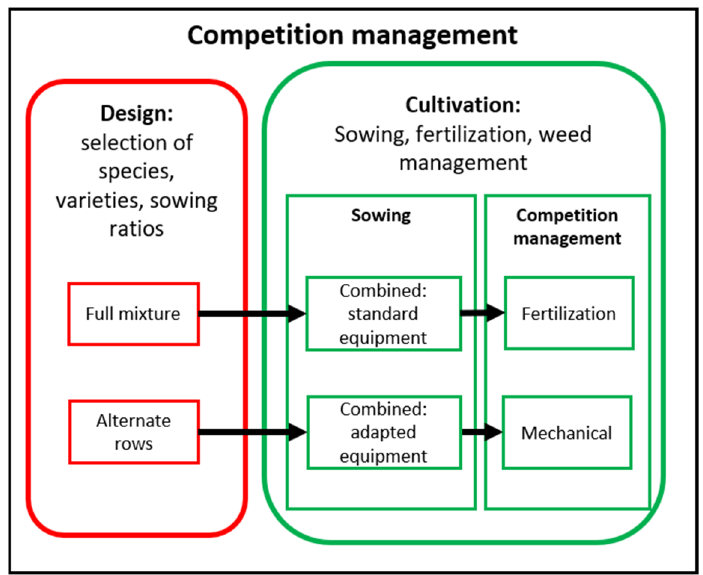
Figure 4. Social representation of the influence of spatial design of mixtures on competition management, interpretatively reconstructed from the interviews with farmers.